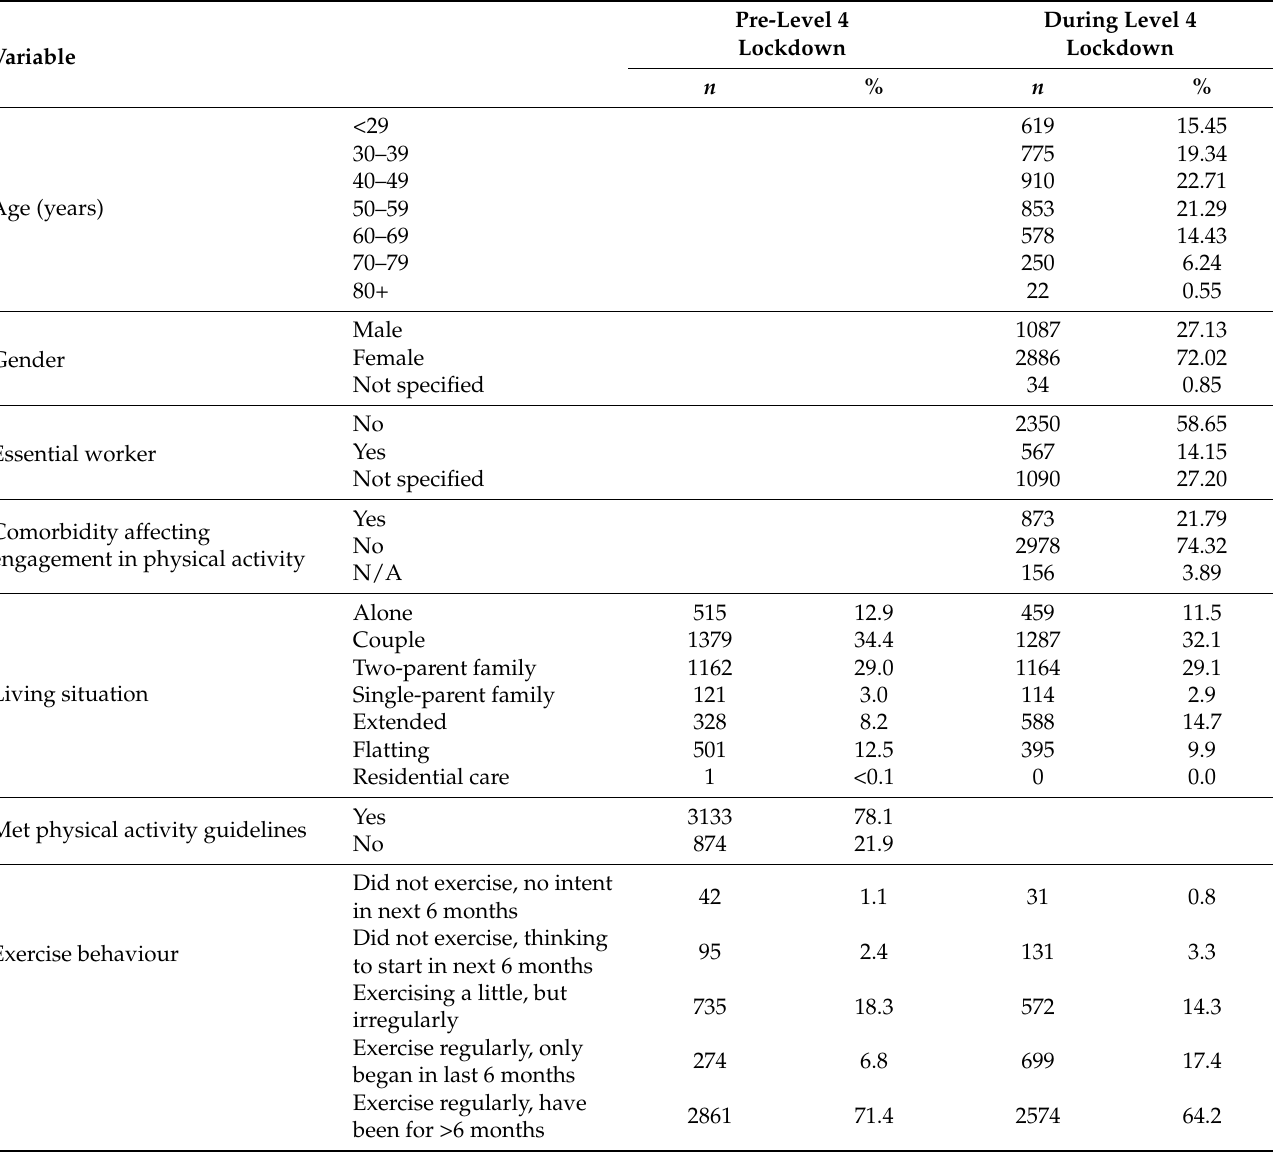
Table 1. Frequencies and percentages of all variables ( n =